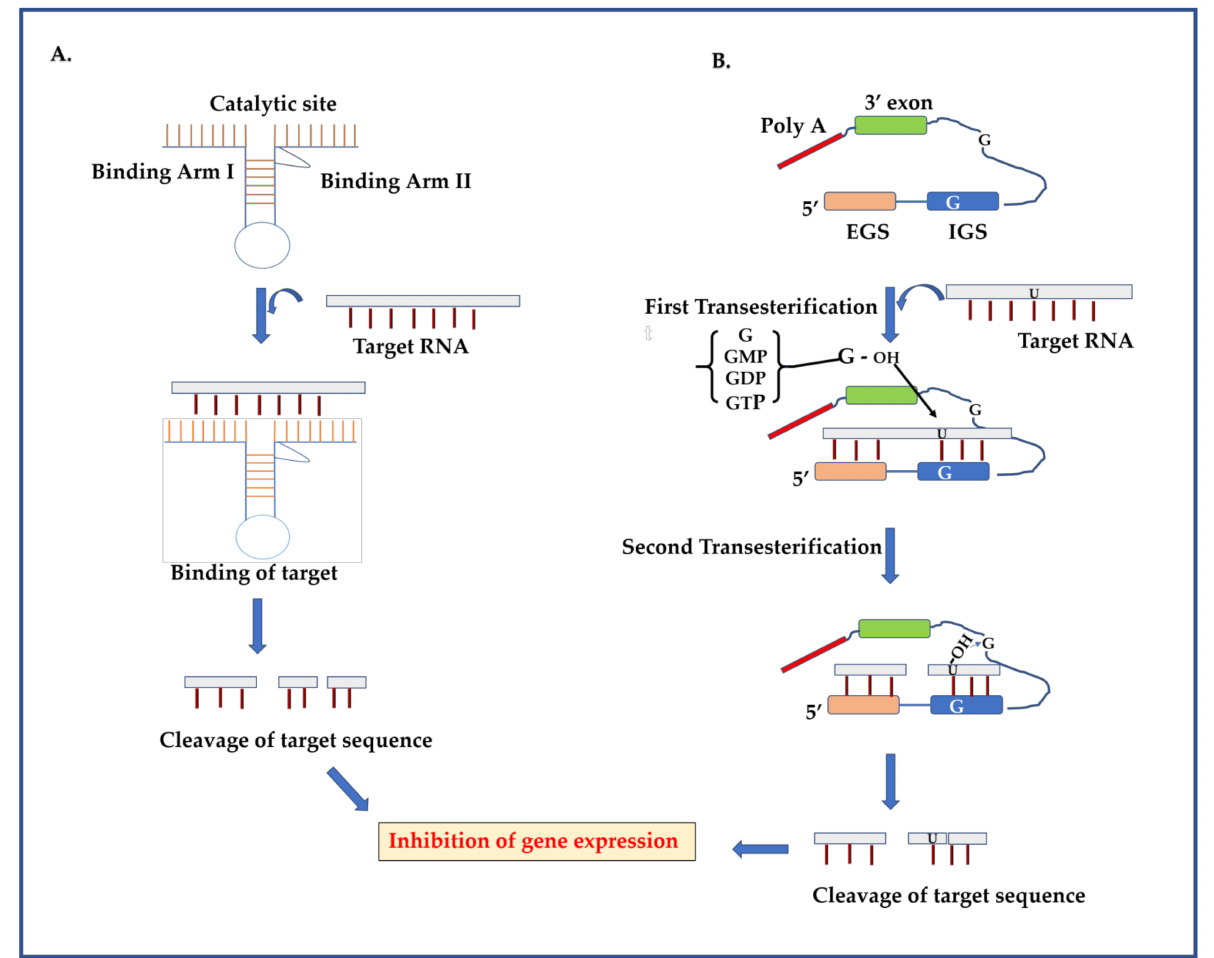
Figure 3. Pathway of gene silencing by the ribozyme-based strategy. ( A ) Hammerhead ribozyme has two binding arms and one catalytic site. The binding arm binds with the target sequence by Watson-Crick base pairing and makes a ribozyme- target complex. The catalytic domain cleaves the target region into small segments and as a result, inhibition of gene expression occurs. ( B ) Group I introns catalyze the trans-splicing reaction. During the first transesterification reaction, –OH group of free-floating guanosines (G/GMP/GDP/GTP) attack phosphodiester backbone which is directly downstream of reactive uracil. The 3 (cid:48) exon then gets positioned at a close proximity towards the newly freed 3 (cid:48) –OH. This 3 (cid:48) –OH group attacks the phosphodiester backbone of group I intron, specifically, just near the upstream of 3 (cid:48) exon. The end result is catalytic cleavage of target RNA into small